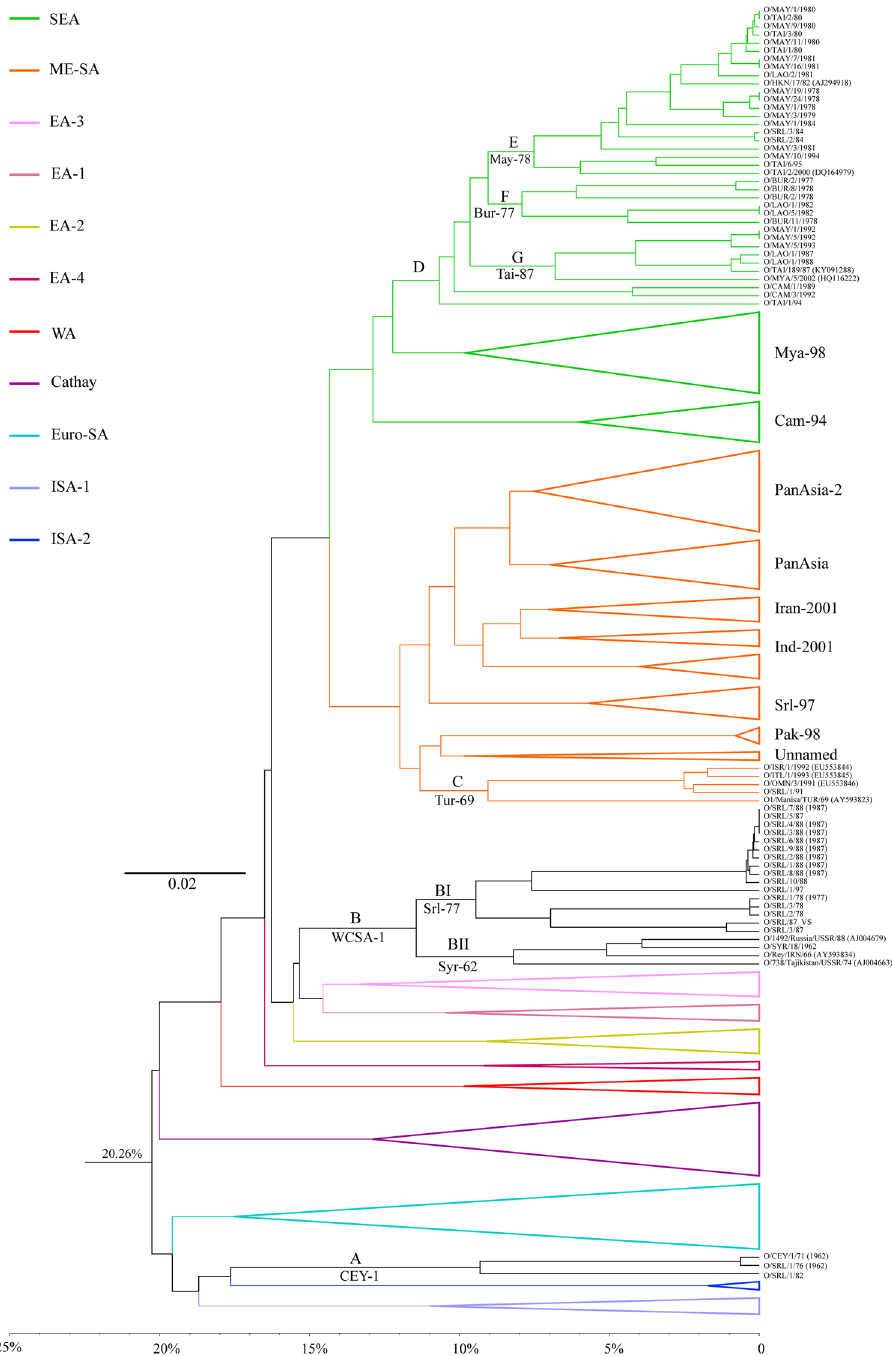
Figure 1. The midpoint rooted distance tree built using UPGMA algorithm. The X-axis represents the nucleotide divergence (ND) calculated using uncorrected pair-wise distances. The colored lines except for the black ones within the tree indicate the known topotypes as depicted in the legend. The collapsed branches represent already known topotypes and lineages. The expanded branches show novel lineages and novel topotypes along with their operational taxonomic units (OTUs). A → G indicate newly formed clades in the tree. The newly assigned names are given below the clades. A and B: Newly named topotypes CEY-1 and WCSA- 1, respectively; BI, BII, C, E, F and G: Newly named lineages; BI: Srl-77; BII: Syr-62; C: Tur-69; D: the clade containing three newly named lineages (E: May-78, F: Bur-77 and G: Tai-87) within the topotype